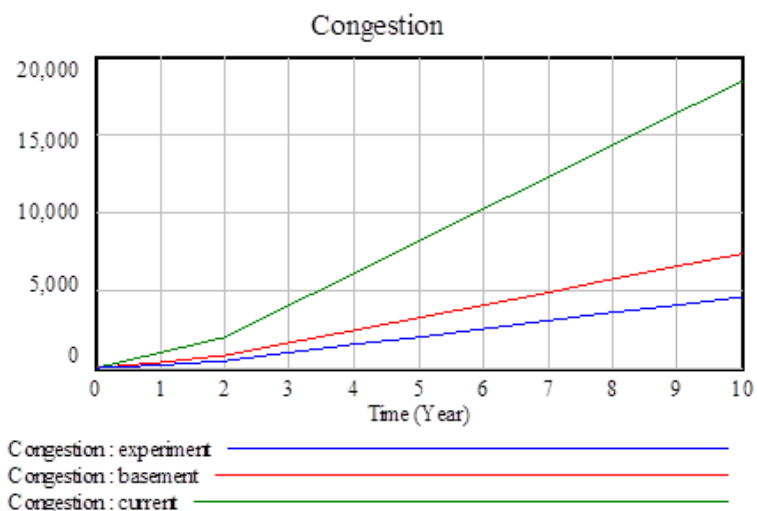
Figure 9. Experiment for CO 2 emission with changes of